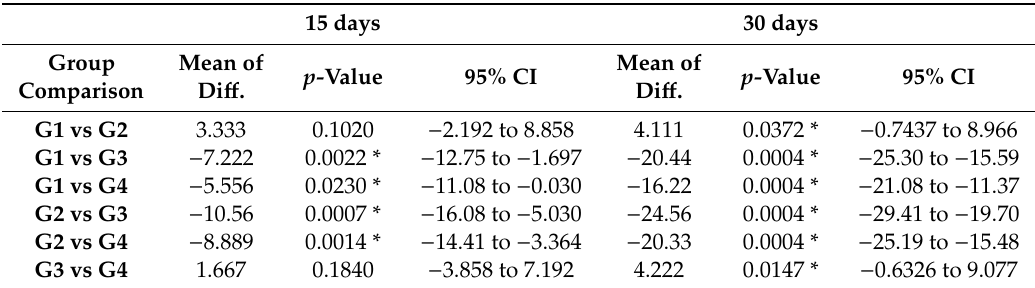
Table 4. Bonferroni’s multiple comparison test to compare the RTv values between the two times with statistically significant difference.